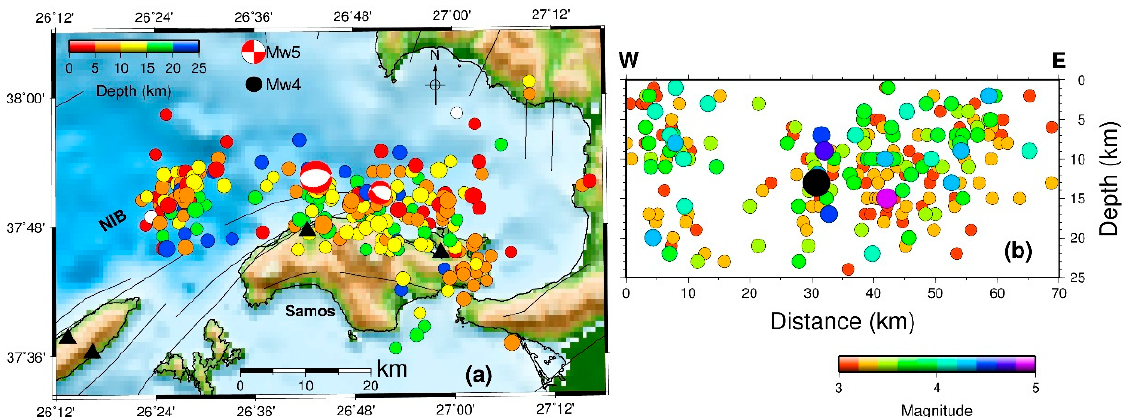
Figure 2. ( a ) Post-seismic activity (M ≥ 3) following the Mw6.9 earthquake (black circle) and its spatial distribution for the period 30 October 2020 to 28 February 2021. ( b ) Depth distribution of the aftershocks (M ≥ 3) along an E–W striking profile. Only earthquakes with M ≥ 3 are presented, since events of smaller magnitude have negligible or even no contribution to the ground displacement.